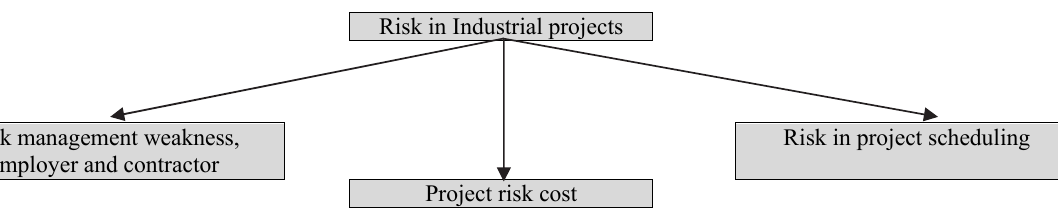
Fig. 1. The structure of the proposed